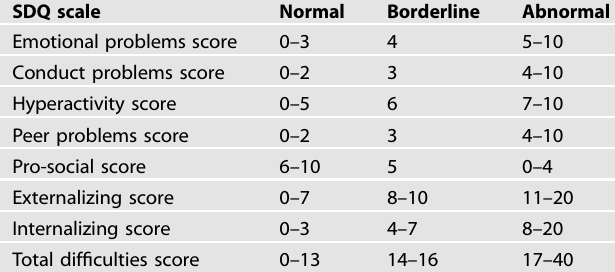
Table 1. Categorization bands for SDQ scores for age 4 – 17